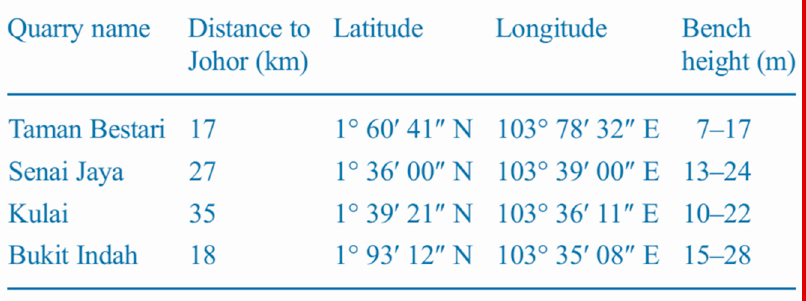
Figure 5. Location information of the quarry sites.